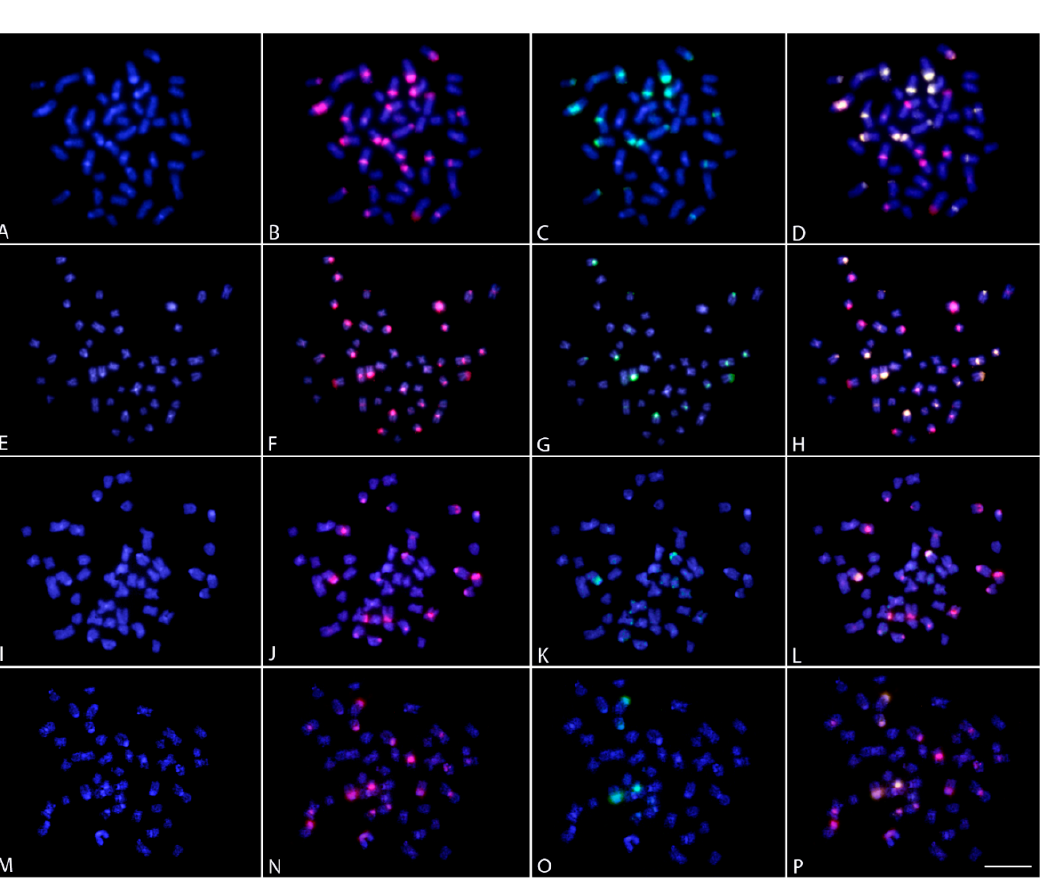
Figure 5. Comparative genomic hybridization (CGH) in metaphase plates of the southern saratoga Scleropages leichardti . First column ( A , E , I , M ): DAPI images (blue); Second column ( B , F , J , N ): hybridization pattern using Scleropages leichardti gDNA probe (red); Third column ( C , G , K , O ): hybridization pattern using the gDNA (green) of the northern saratoga Scleropages jardinii ( C ); Asian arowana Scleropages formosus ( G ); black arowana Osteoglossum ferreirai ( K ); silver arowana Osteoglossum bicirrhosum ( O ); Fourth column ( D , H , L , P ): merged images of both genomic probes and DAPI staining. The common genomic regions are depicted in yellow. Bar = 5 µm.